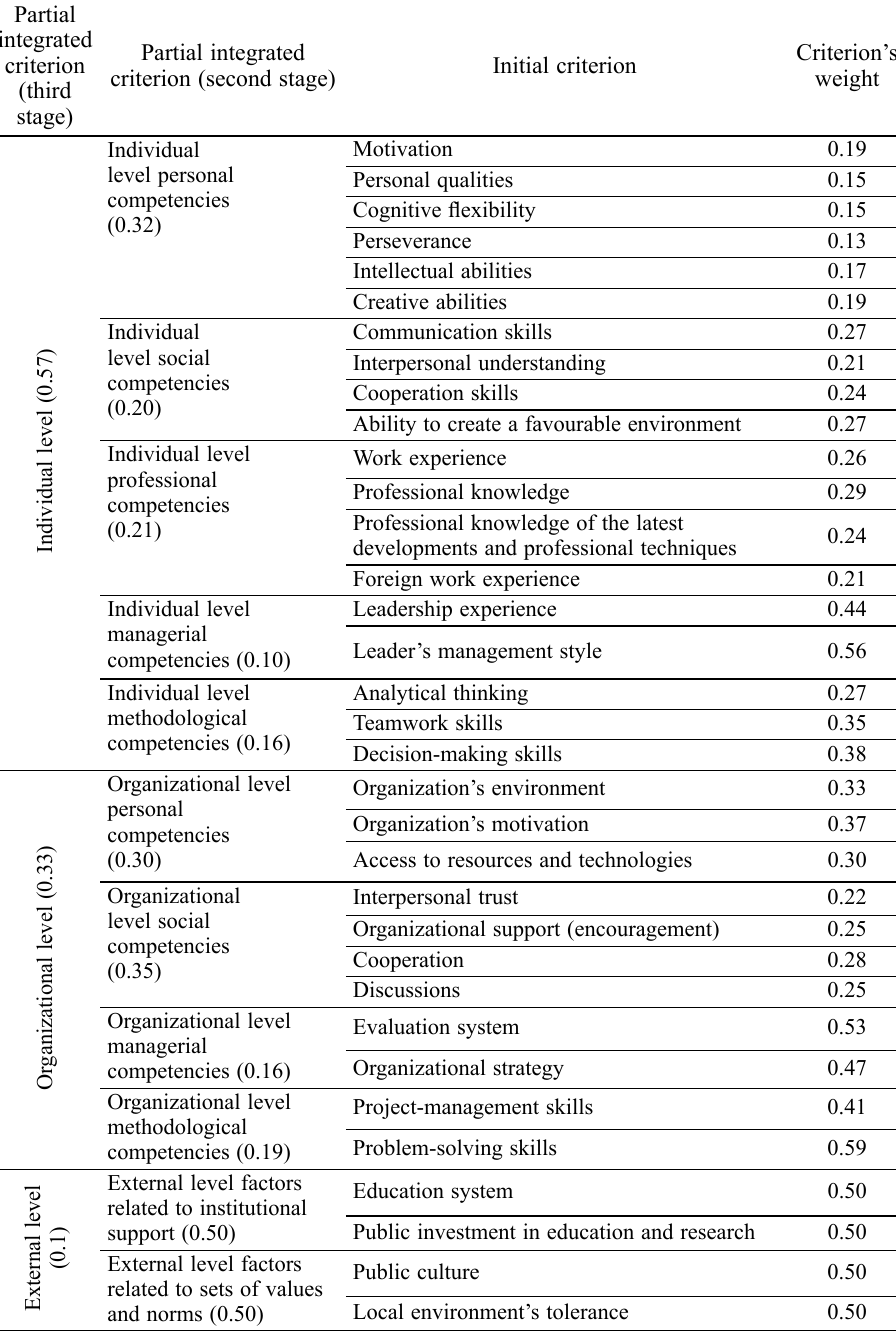
Table 1. The dentification of factors affecting creativity by applying the method of the determination of the significance of the